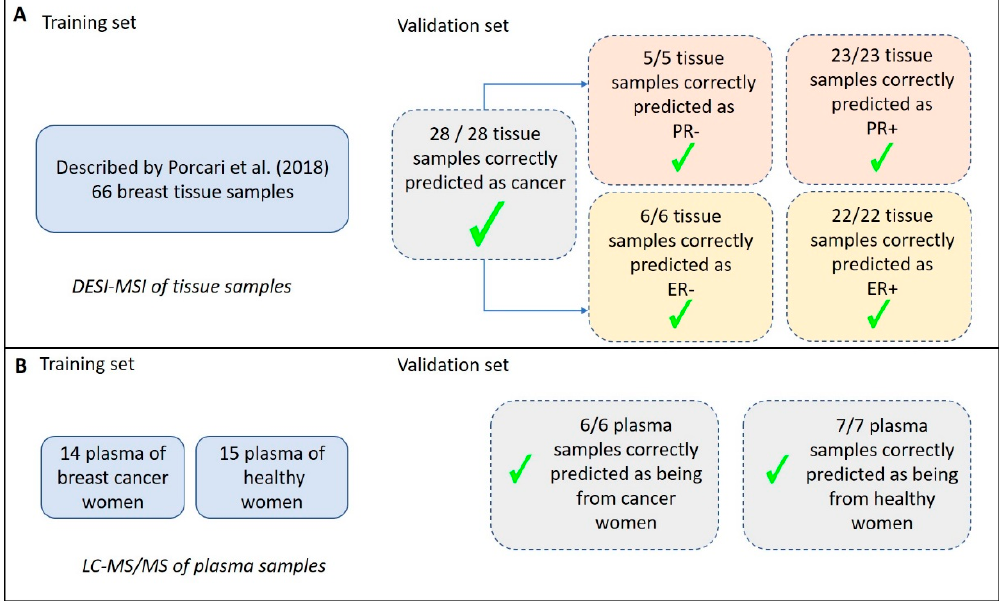
Figure 2. Summary of the classification predictions of breast carcinoma tissue and plasma samples. ( A ) Results obtained for tissue analysis using DESI-MSI (Desorption-Electrospray-Ionization—Mass Spectrometry Imaging). A previously validated model for classification of samples was described by Porcari et al. [28], with 66 breast cancer samples compared to normal breast tissue, and it was used here as a test set. In the validation set, all the NST (no special type) and special type tissue samples were correctly classified as being cancer and as having +/ - Progesterone Receptor (PR) and +/ - Estrogen Receptor (ER). ( B ) Describes the results obtained for plasma analysis using LC-MS / MS (Liquid Chromatography—tandem Mass Spectrometry). The test set was composed of 29 plasma samples and resulted in average accuracies of 99.8% (positive ion mode) and 99.2% (negative ion mode) based on 100 cross-validations. In the validation set, including 30% of the samples, all the plasma samples were correctly classified as being cancer or not.